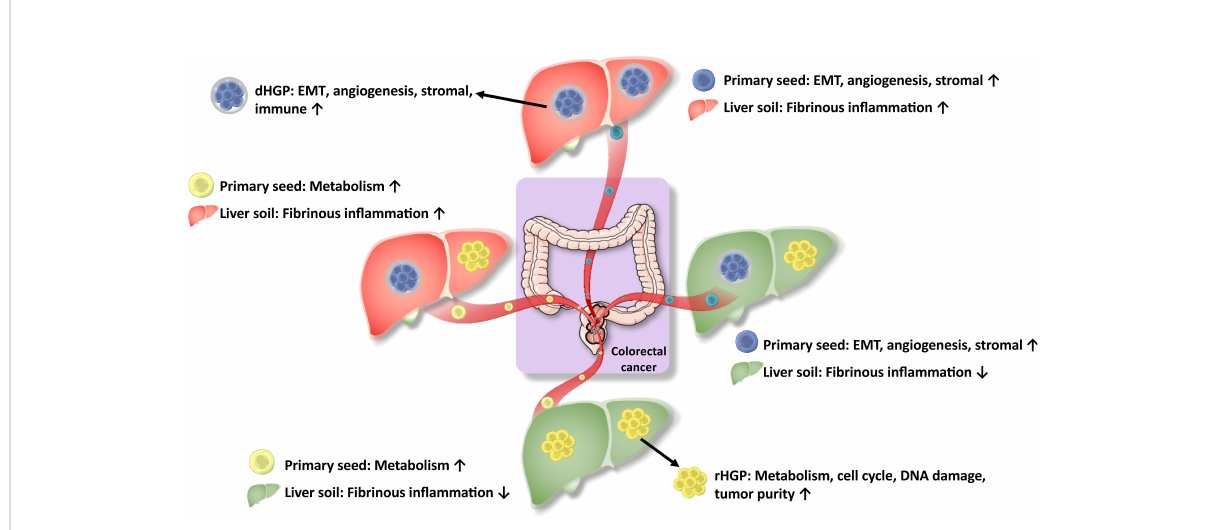
FIGURE 7 Hypothesis for regulation of molecular expressions for HGPs. HGPs are observable morphological changes resulting from the regulation of molecular expressions, which is the combined effect of the heterogeneity and remodeling of primary tumors seeds and liver